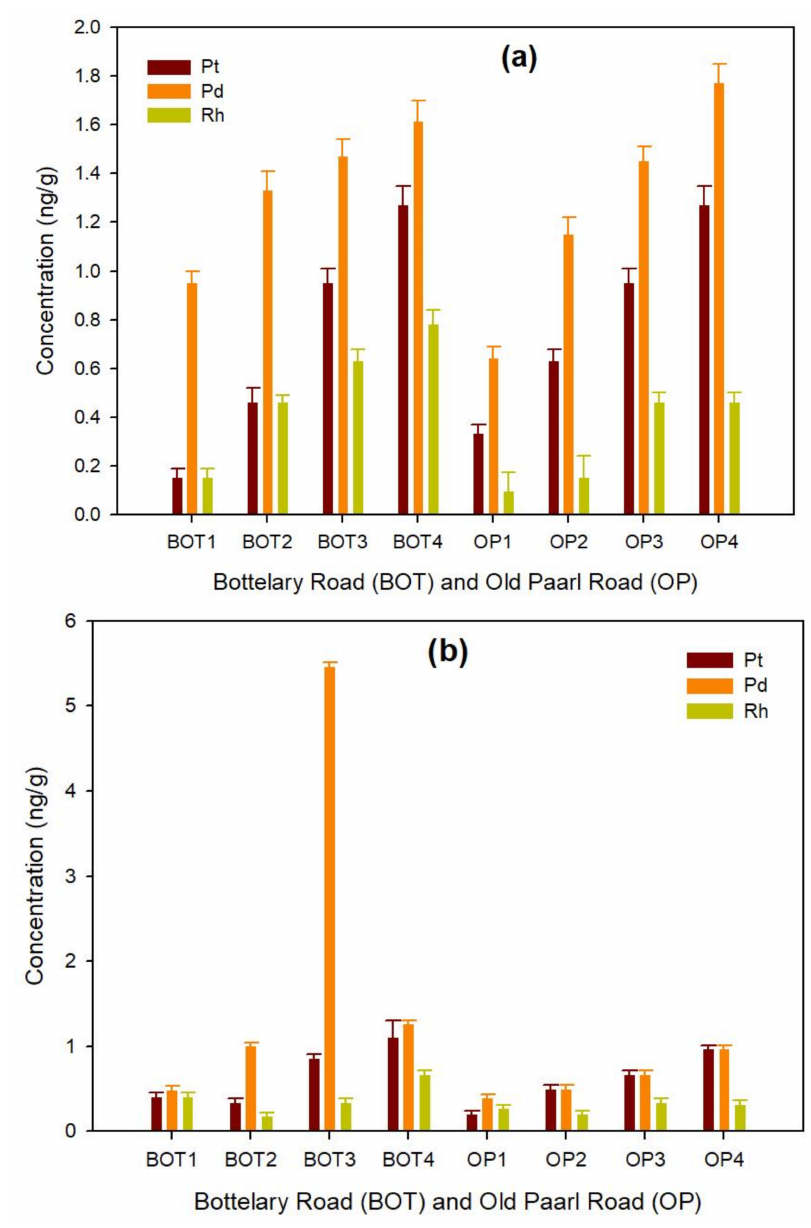
Figure 2. ICP-QMS results for Pt, Pd, and Rh concentrations in roads dust ( a ) and roadside soil ( b ) samples on Bottelary Road (BOT) and Old Paarl Road